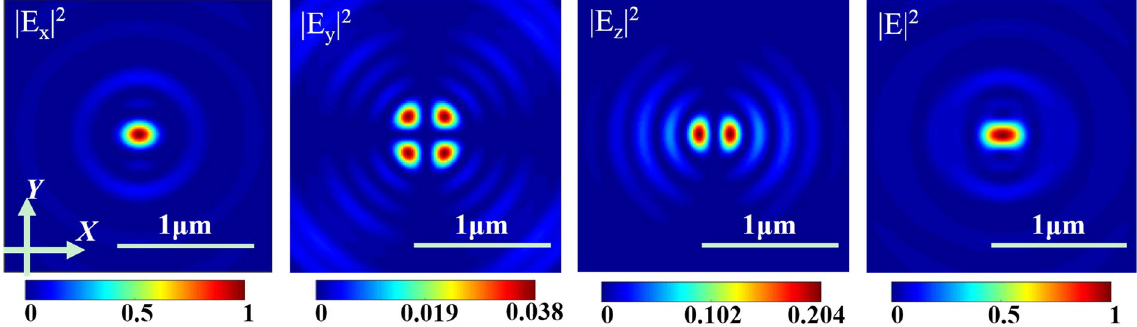
Figure 4. Normalized electric-field patterns for the first focus of SOL #1 achieved by the FDTD simulation.